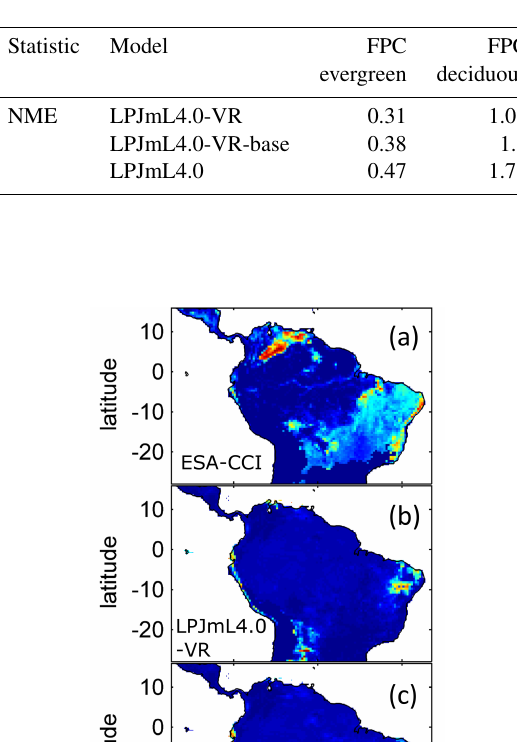
Table B4. Normalized mean error (NME) of FPC comparison piecewise calculated between (1) the satellite-derived vegetation composition from ESA Land Cover CCI V2.0.7 (Li et al., 2018) reclassified to the PFTs of LPJmL as in Forkel et al. (2014) and (2) all LPJmL model versions used in this study forced with CRU climate data (in accordance with Fig. 4).